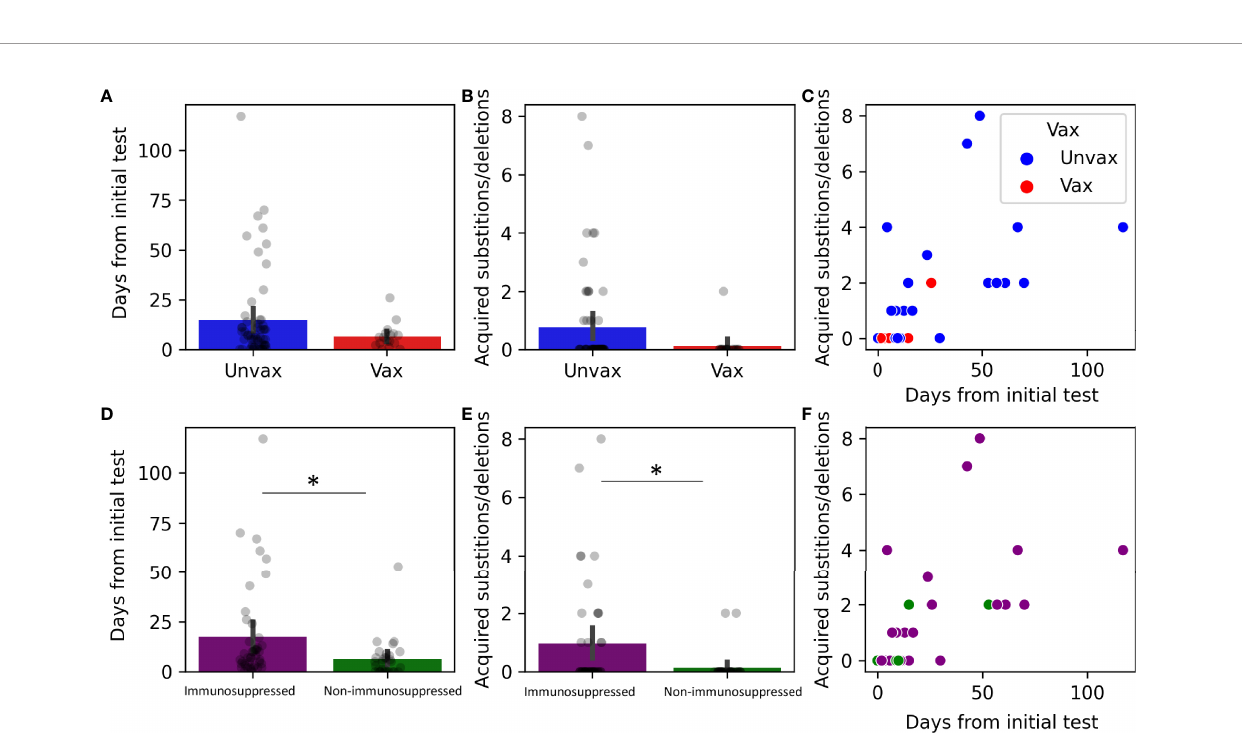
FIGURE 6 | Genomic changes in prolonged viral shedding by vaccination and immune status. Substitutions and deletions in 75 patients by status: vaccinated (N =17, A – C ) and immunosuppressed (N=44, D – F ). (A, D) Barplots with overlayed strip plots of mean time of prolonged shedding of complete genomes in each group, (B, E) Barplots with overlayed strip plots of amino acid change frequency in each group, (C, F) Scatterplots of the correlation of amino acid change and the days after the fi rst positive in each group. *p < 0.05. Unvax, unvaccinated; Vax,